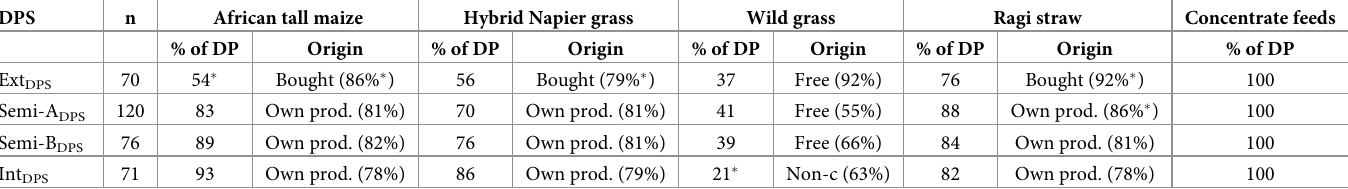
Table 2. Feeding frequency (in % of Dairy Producers (DP)) of the most common forages and concentrate feeds utilized in Bengaluru’s Dairy Production Systems (DPS), and, when fed by a dairy producer, their most frequent origin (own production (Own prod.), bought (Bought), collected for free from public grounds or as waste (Free) or collected on own ground but not cultivated